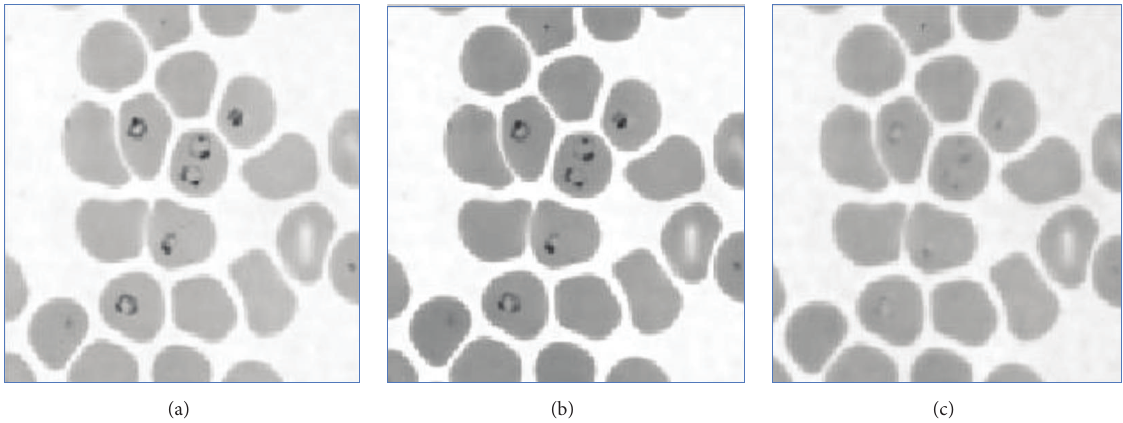
Figure 5: Separated RGB bands: (a) R band, (b) G band, and (c) B